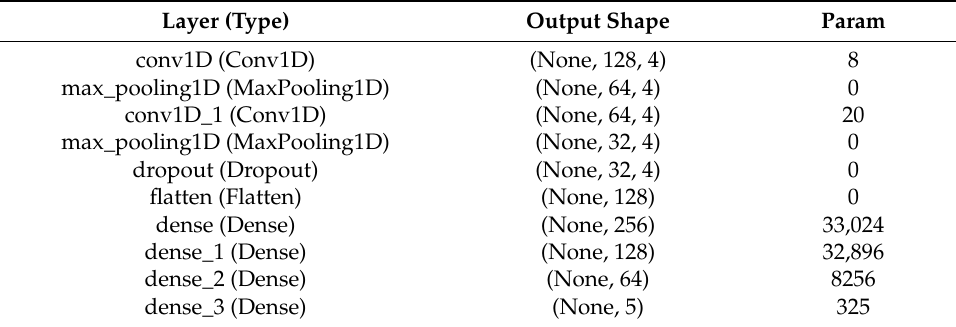
Table 3. The structure of the developed 1-D CNN model.